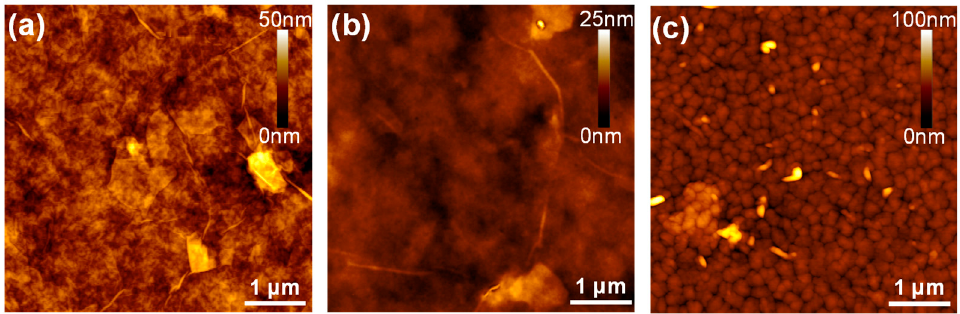
Figure 2. Height-mode AFM topographs of ( a ) GO film, ( b ) polystyrene (PS)-coated GO (GO/PS) film, and ( c ) pentacene film deposited on GO/PS bilayer dielectric.